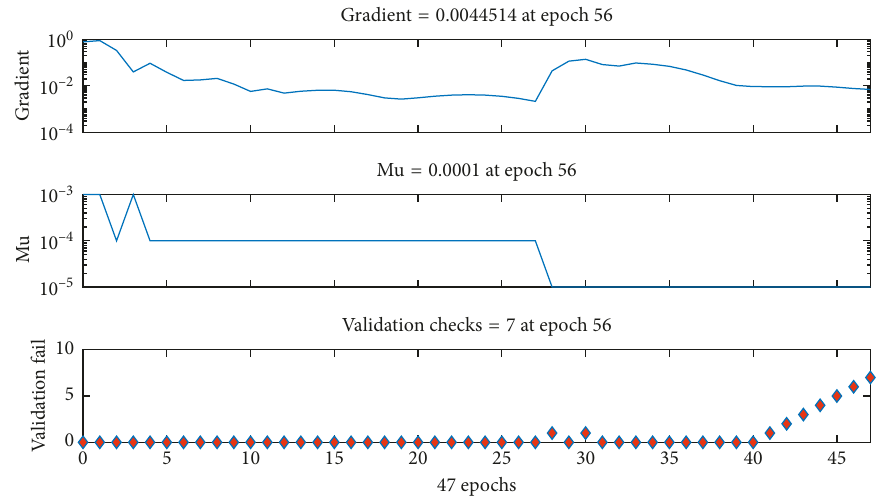
Figure 5: Significant controlling parameters changing with